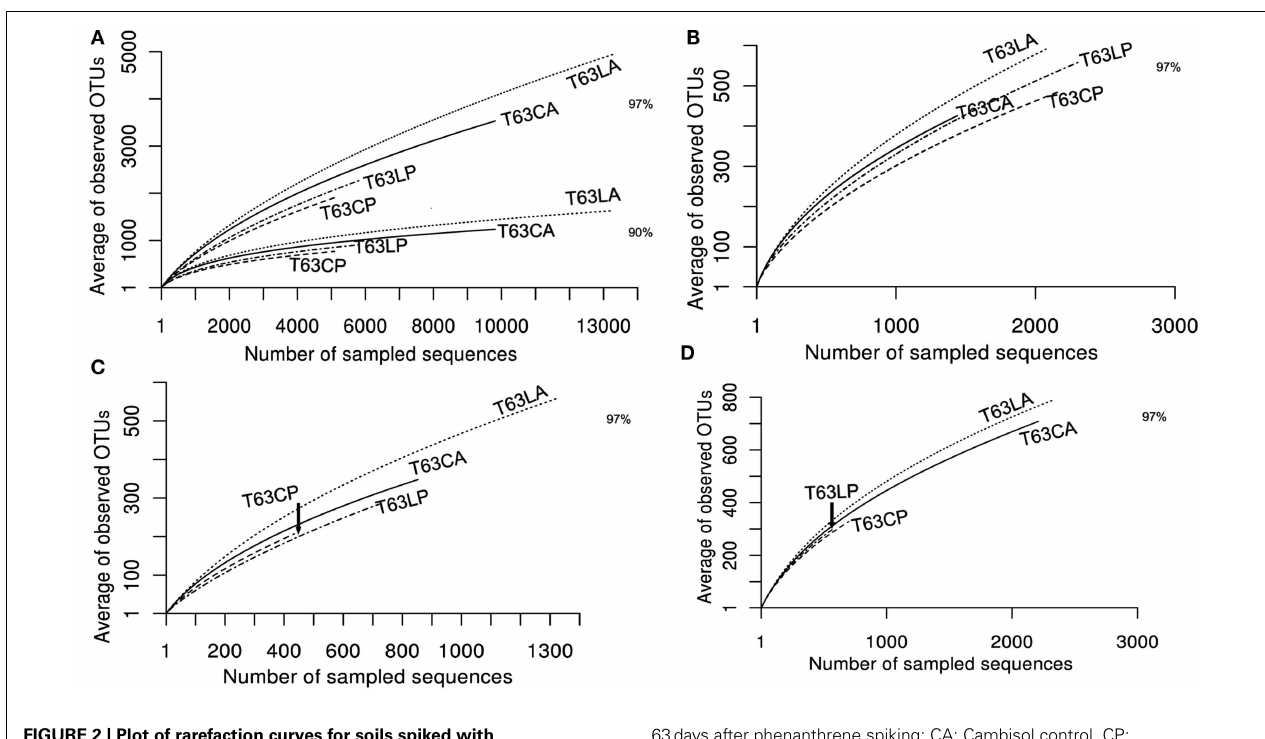
FIGURE 2 | Plot of rarefaction curves for soils spiked with phenanthrene (LP, CP) or not (LA, CA) on day 63. (A) Total bacteria; (B) Alphaproteobacteria ; (C) Betaproteobacteria ; (D) Actinobacteria .T63,